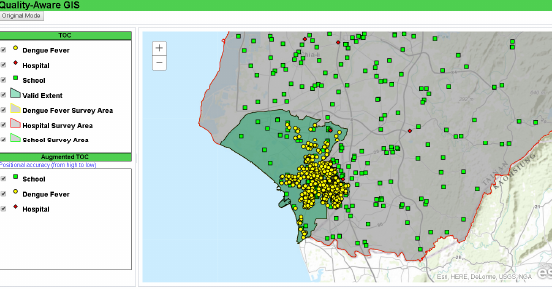
Figure 8. Survey areas of all datasets (gray filling with yellow, green and red outlines)